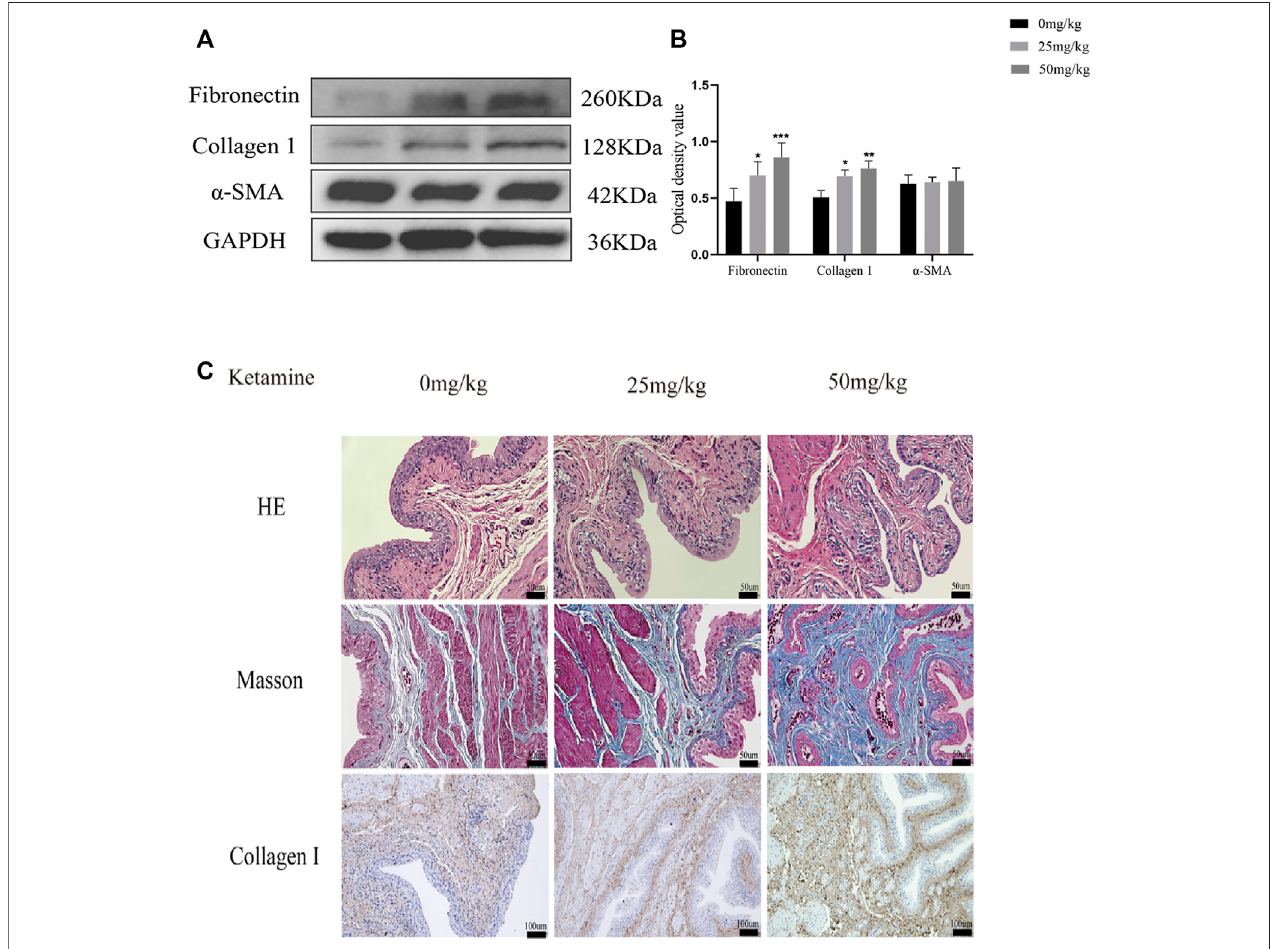
FIGURE2| Ketamineinduced fi broticchangesinrat ’ sbladder. (A) Representativebandsfrom Western blot analyses ofthelevels ofthe fi bronectin,collagen Ⅰ and α -SMA proteins in rat bladder tissue after being treated with different concentrations of ketamine (treated for 12 w). (B) Relative levels of the fi bronectin and collagen Ⅰ proteins compared to GAPDH. * P < 0.05 compared with 0 mg/kg, ** p < 0.01 compared with 0 mg/kg; *** p < 0.001 compared with 0 mg/kg; **** p < 0.0001 compared with 0 mg/kg. (C) Representative micrographs of HE staining and Masson ’ s trichrome staining and IHC staining for collagen Ⅰ in rat bladder tissue. Scale bar in HE staining and Masson ’ s trichrome staining is 50 μ m; in IHC for collagen Ⅰ staining is 100 μ m (treated for 12 w). N (cid:1) 3.